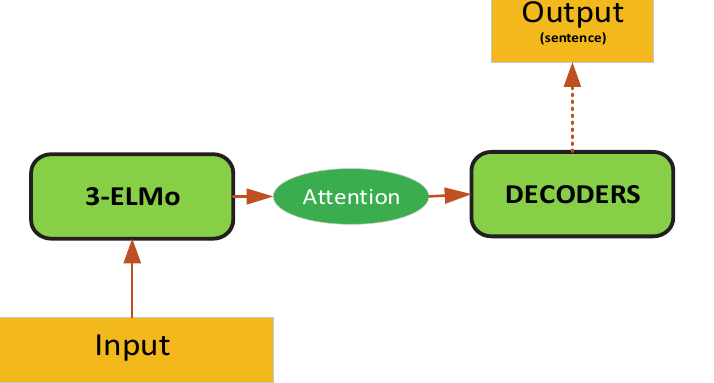
Figure 4. 3EAG model structure.